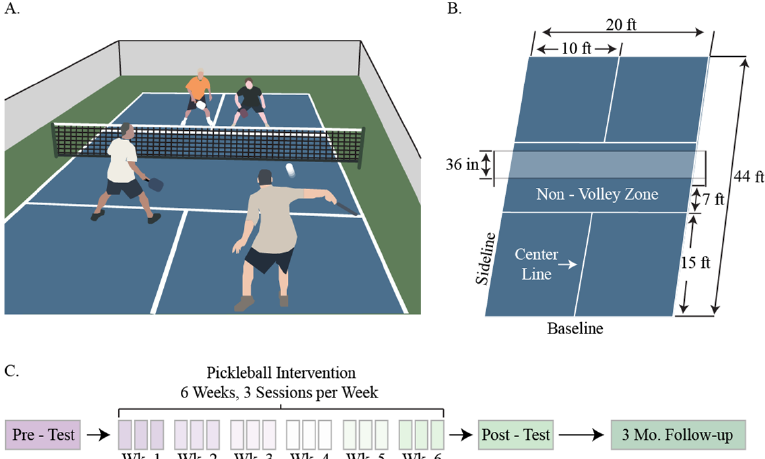
Figure 1. Description of the game pickleball and summary of the experimental design. ( A ). Pickleball is played between two teams of two where, similar to tennis, the goal is to gain points by having the other team be unable to return the ball. ( B ). Pickleball is played on a 44 ft by 20 ft court using a ping-pong-like paddle and a whiffle ball. Pickleball differs from tennis in that the ball must be served underhand and players cannot approach the net to volley (Non-Volley Zone). ( C ). Outline of the experimental design. The study was conducted with physiological measures recorded before and after a 6-week, 3 session per week pickleball intervention. Three months following the post-test, we administered a qualitative follow-up questionnaire examining participants’ perceptions of the intervention. Wk. = week, Mo. =